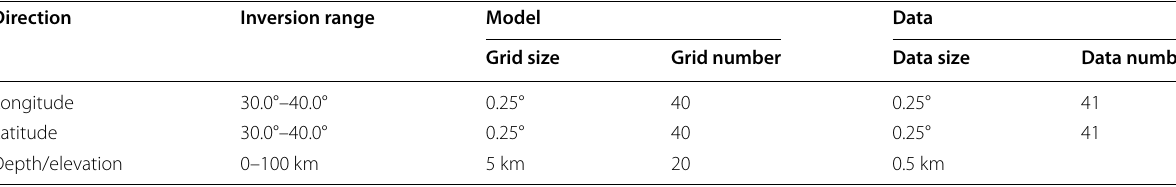
Table 1 3D mesh and dataset for inversion